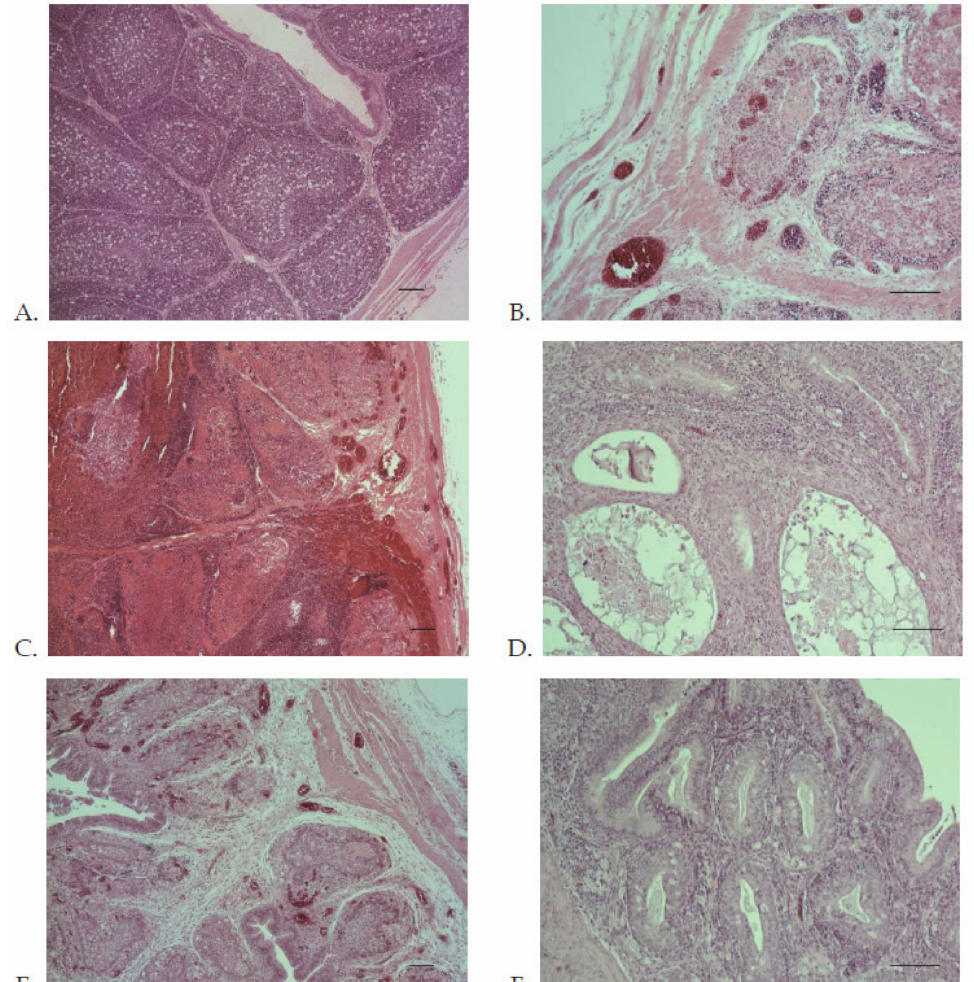
Figure 7. Histopathology of the bursa of Fabricius of SPF chickens. ( A ) The control group at 10 dpi (group D). ( B ) Group C inoculated with reference very virulent strain 75/11/Poland/2011 at 4 dpi. ( C , D ) Group A inoculated with Bug/03/Poland/2003 at 3 and 10 dpi, respectively. ( E , F ) Group B inoculated with 117/14/Poland/2014 at 3 and 10 dpi, respectively. The magnification is represented by the black band (short = × 50, long = ×